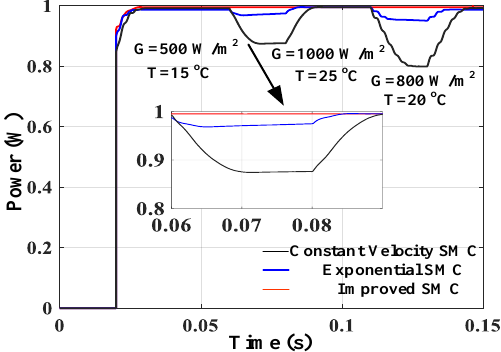
Figure 17. Efficiency curve under varying G , T .